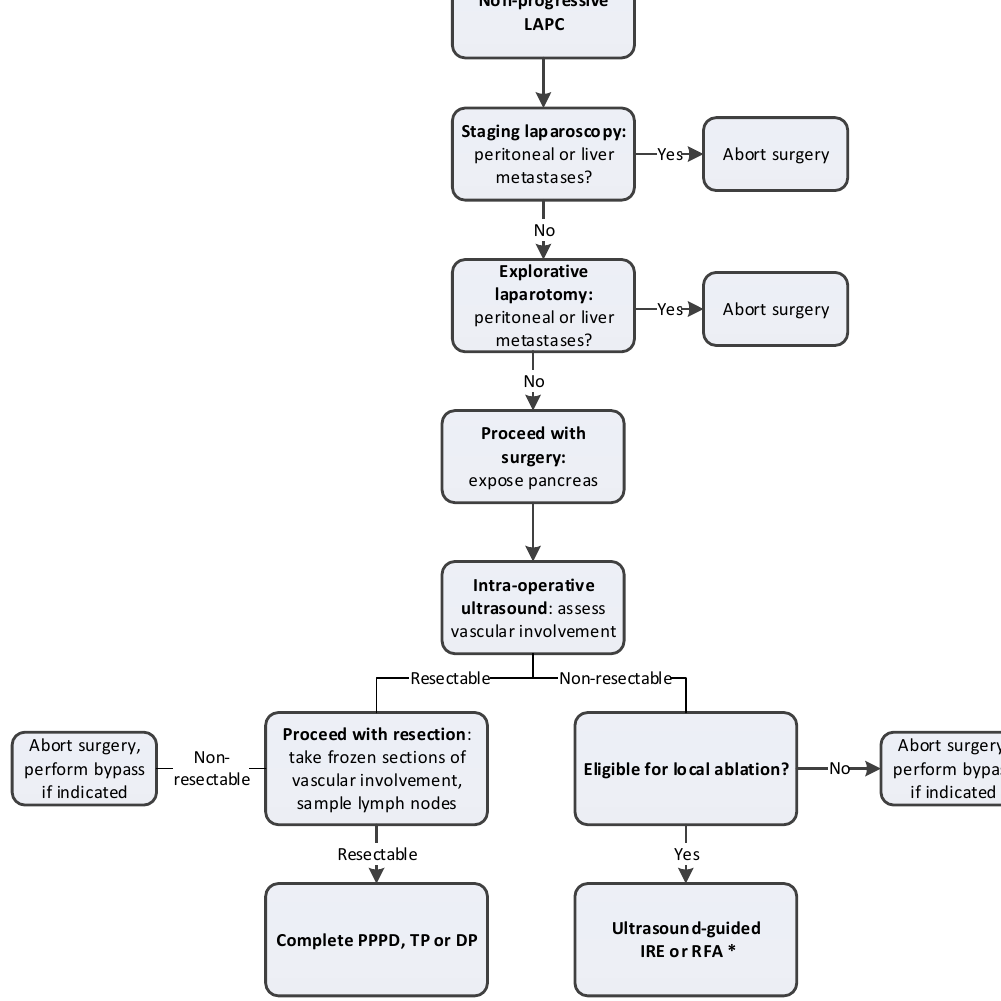
Figure 1. Overview of surgical procedure of LAPC after induction chemotherapy. * Since randomized studies confirming the efficacy of ablation in LAPC are lacking, patients should preferably be treated within the context of clinical trials; LAPC: locally advanced pancreatic cancer; PPPD: pylorus-preserved pancreatoduodenectomy; TP: total pancreatectomy; DP: distal pancreatectomy; IRE: irreversible electroporation; RFA: radiofrequency ablation.